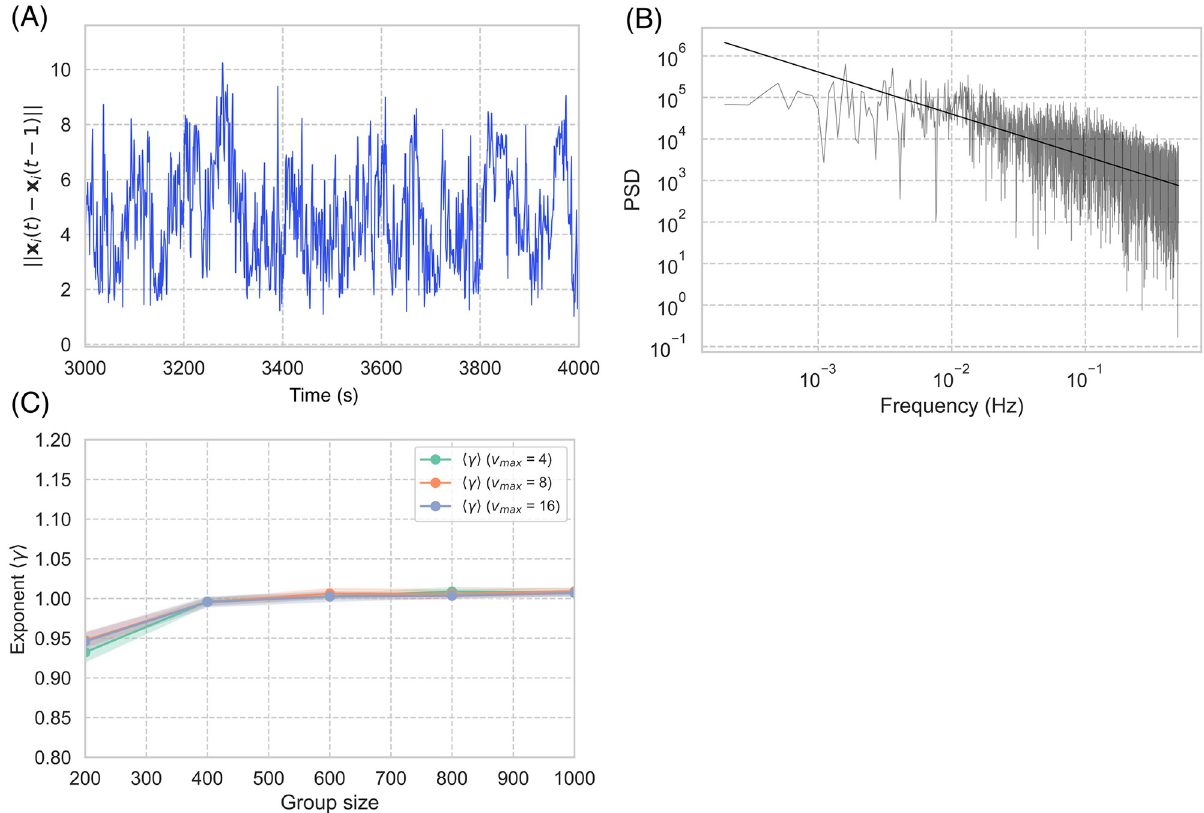
Fig 5. Jittering behavior on center-of-mass reference frame. (A) Sample velocity variation time series (i.e., || x (A): the slope of f − γ is 0.98 (solid line). (C) Average slope h γ i according to group size for different velocity V parameters, with h γ i converging to 1.0. The jittering behavior of each agent is highly self-organized in